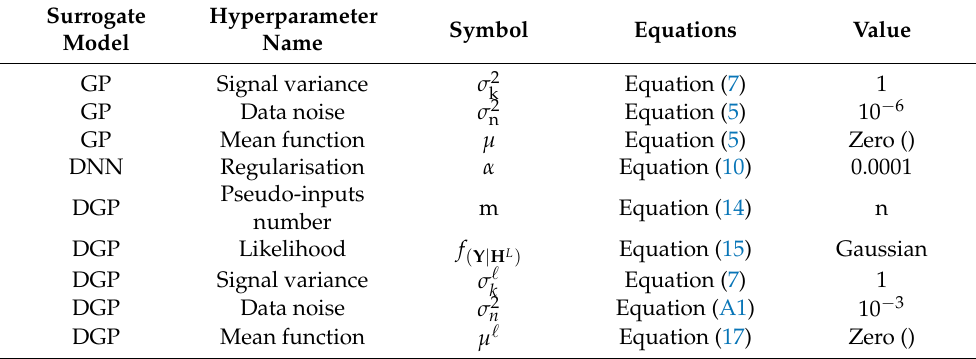
Table 7. Fixed hyperparameters for the GP, the DNN and the DGP.